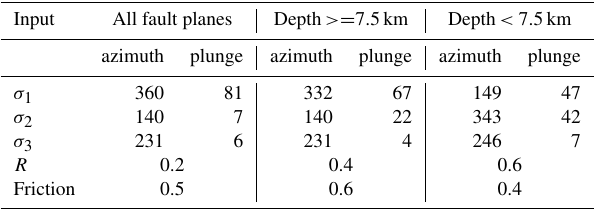
Table 3. Result of the stress inversion for all events, deep events and shallow events. Azimuth and plunge angles in ◦ . R is the shape